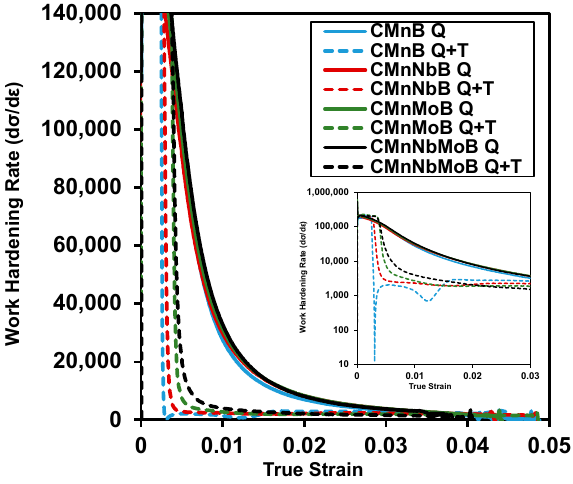
Figure 14. Work hardening rate as a function of true strain for all samples after Q and Q + T treat- ments.